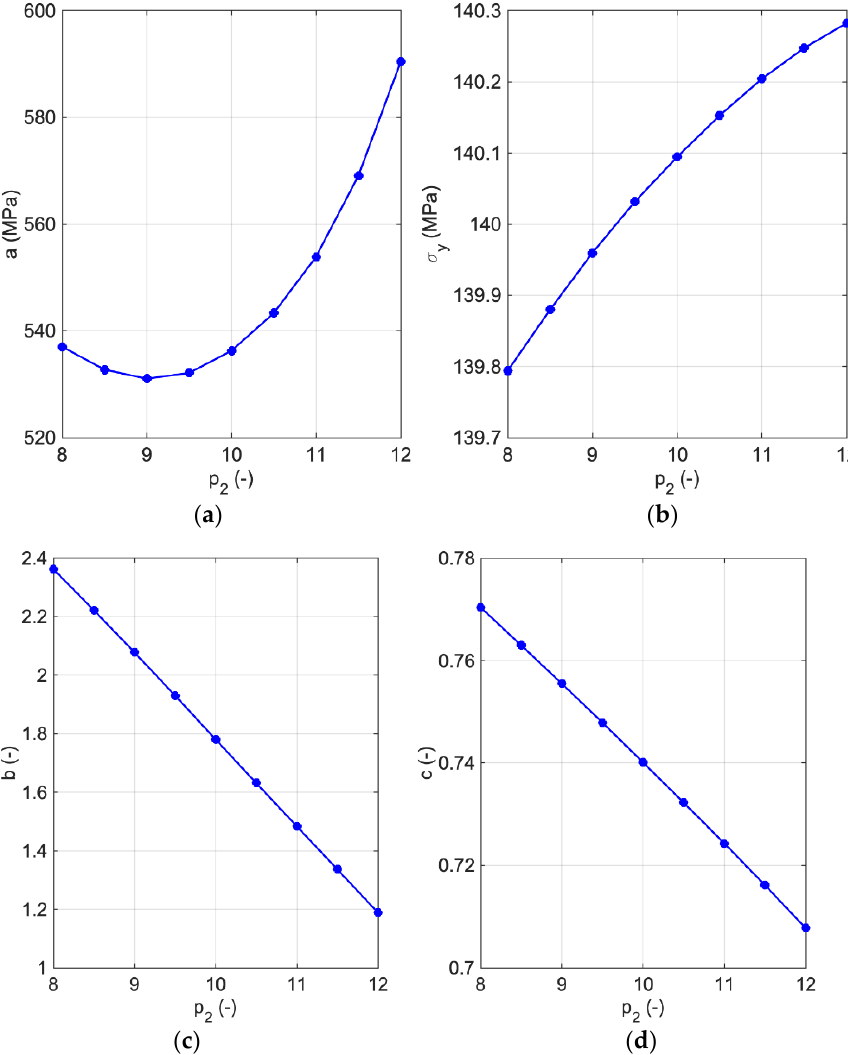
. 2 . Figure 9. Comparison between numerical results and fitted curves with change in p 2 . 2